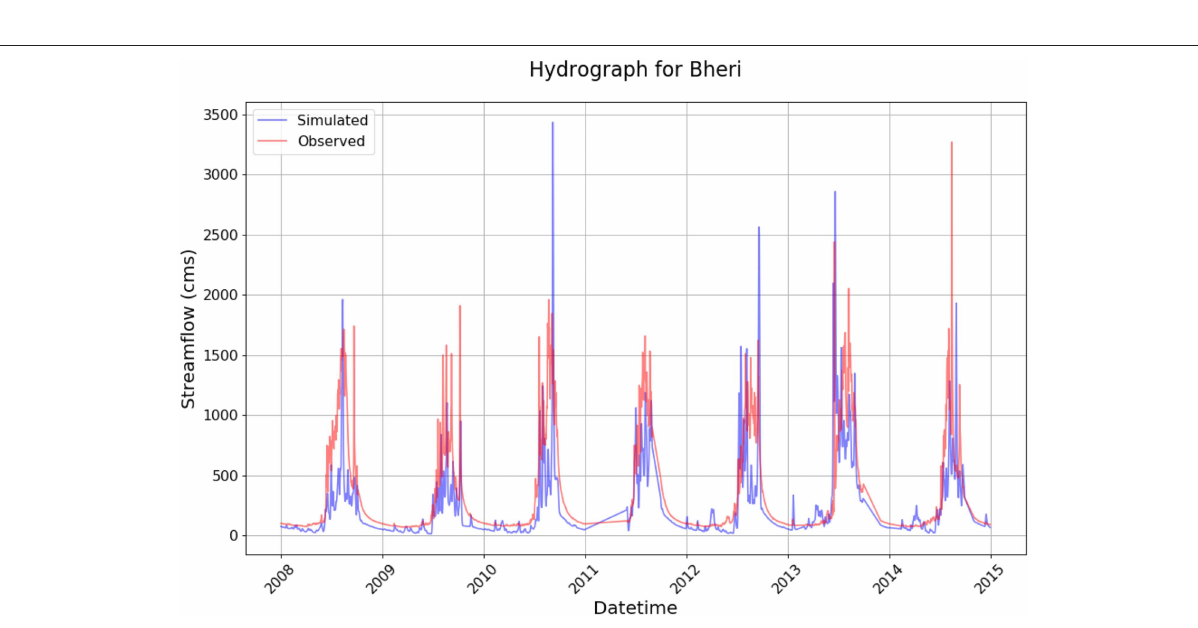
FIGURE 12 | Simulated vs. observed data for Bheri station in